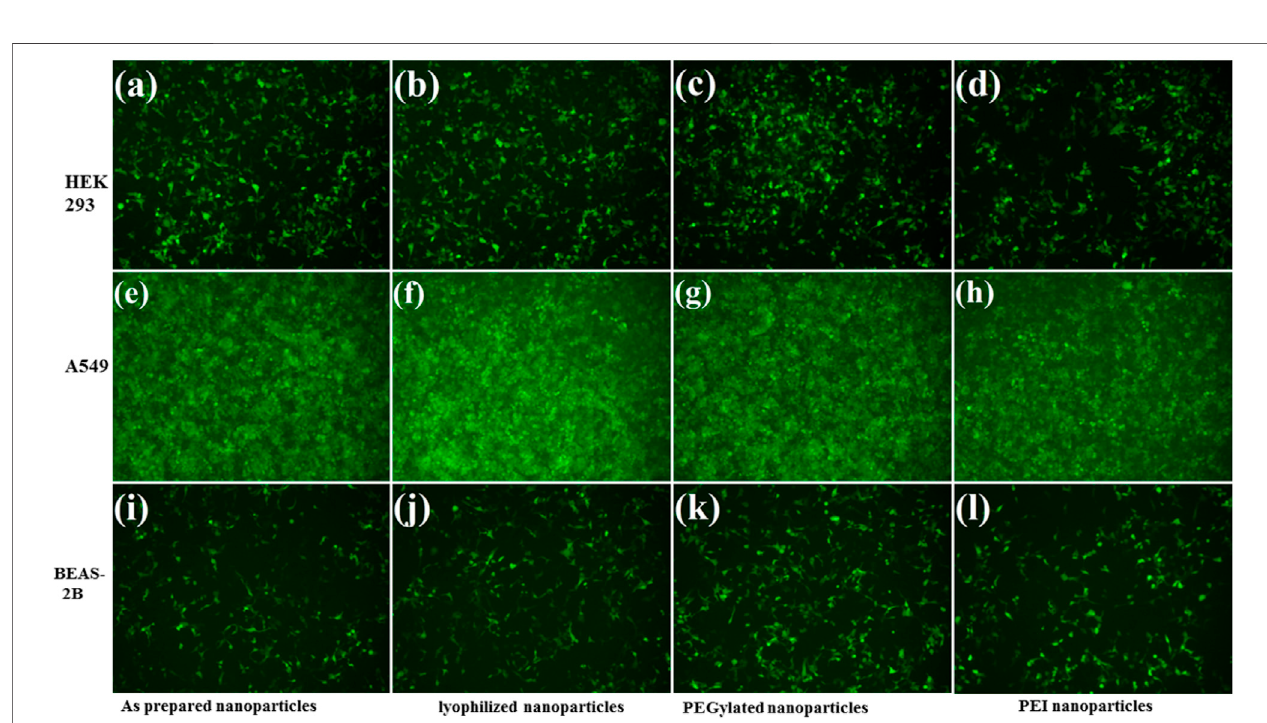
FIGURE8| Transfectionef fi ciencyofP β AE-447/pDNAnanoparticlesindifferentcellsafterincubationfor4 hourswithas-preparedP β AE-447/pDNAnanoparticles (A,E,I) , lyophilized P β AE-447/pDNA nanoparticles (B,F,J) , PEGylated P β AE-447/pDNA nanoparticles (C,G,K) and PEI (D,H,L) .